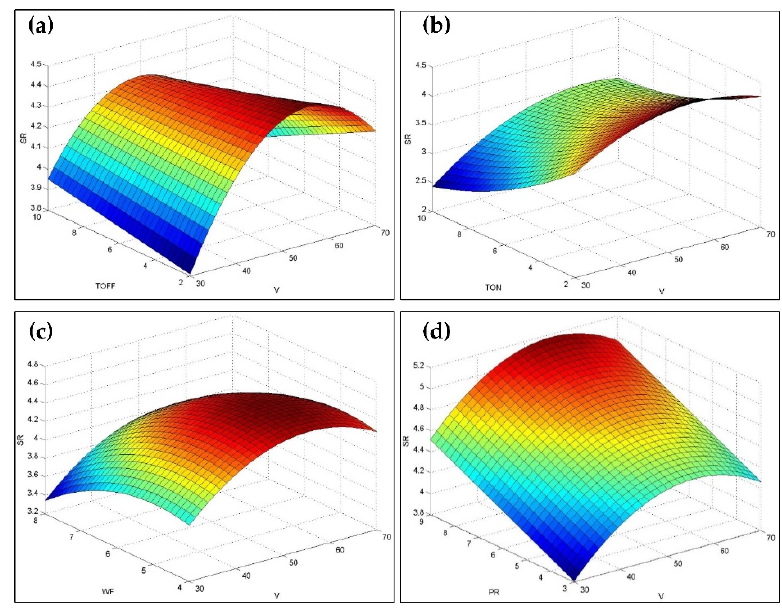
Figure 9. ( a – d ). Influence of WEDM parameters on surface roughness.